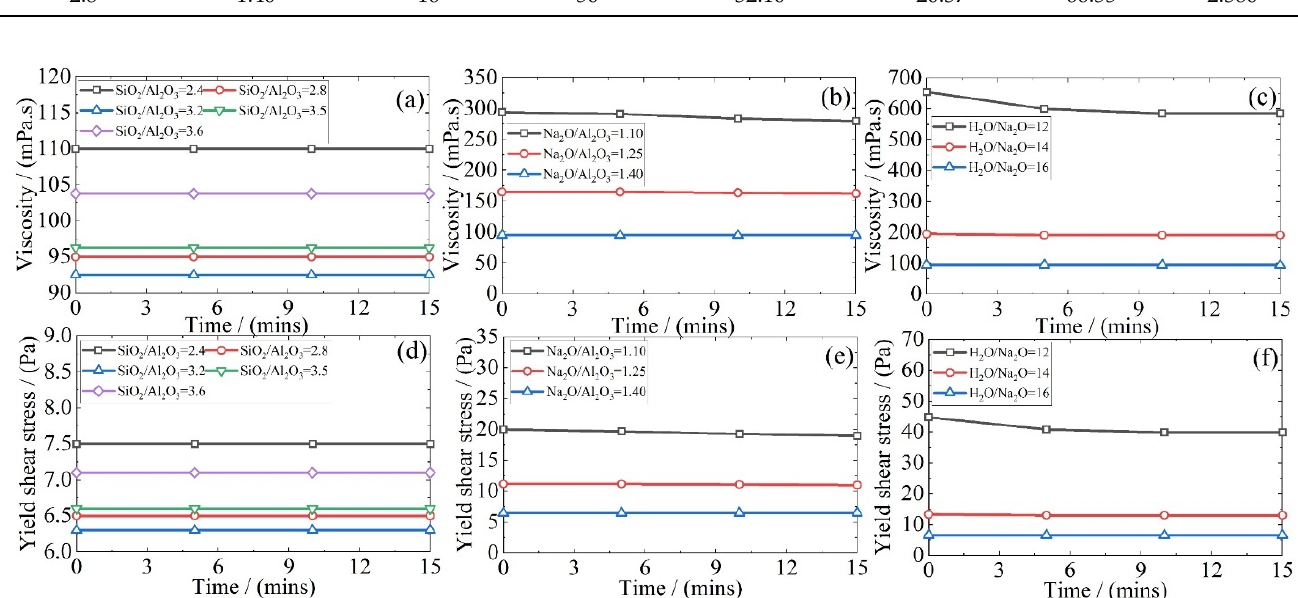
Figure 2. Rheological properties of fresh geopolymer mixtures made with varying compositional ratios: ( a – c ) viscosity and ( d – f ) yield shear stress.